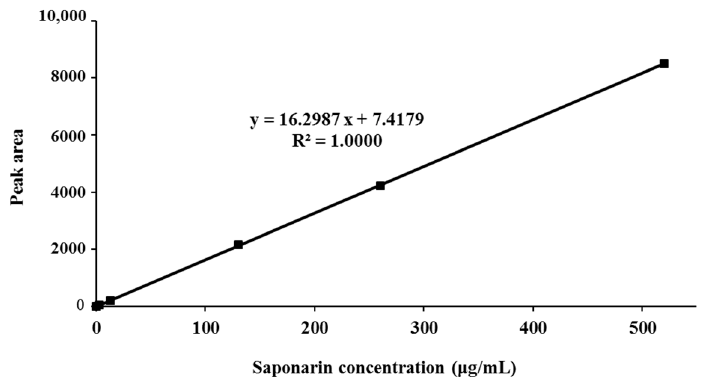
Figure 1. Calibration curve for saponarin standard. y, peak area (mAU) of saponarin; x, concentration ( μ g/mL) of saponarin; R 2 , correlation coefficient.